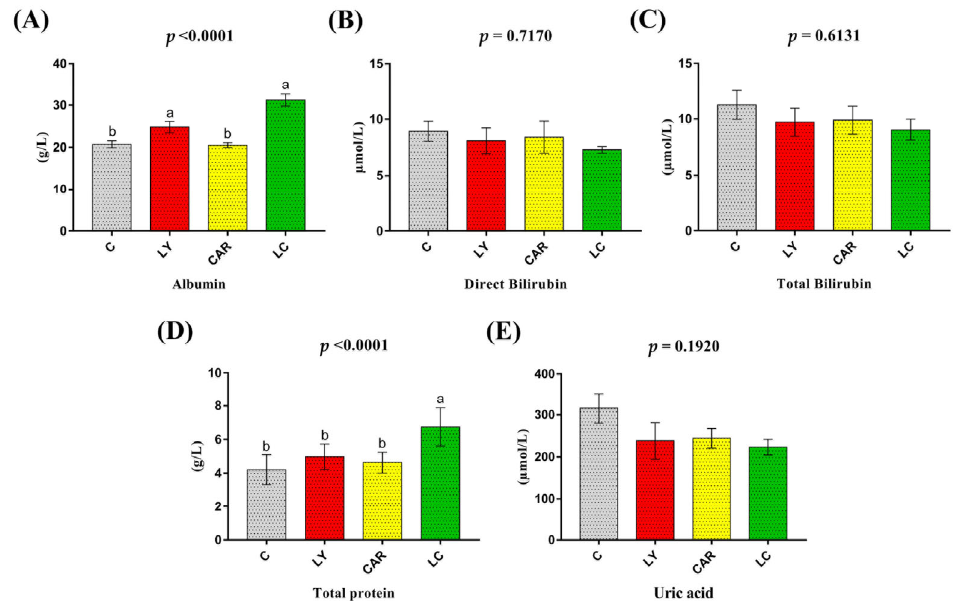
Figure 4. Effects of Antioxidants combination supplementations on the serum biochemical indexes of Roosters. ( A ), Albumin; ( B ), Direct Bilirubin; ( C ), Total Bilirubin; ( D ), Total protein; ( E ), Uric acid. Data are presented as mean value ± SEM ( n = 8). Values without the same letter (a, b) represent statistically significant differences ( p < 0.05). Abbreviations: C, Roosters fed a basal diet; LY, Roosters fed a basal diet supplemented with 400 mg/kg Lycopene; CAR, Roosters fed a basal diet supplemented with 150 mg/kg L-Carnitine; LC, Roosters fed a basal diet supplemented with (400 + 150) mg/kg Lycopene and L-Carnitine in combination.